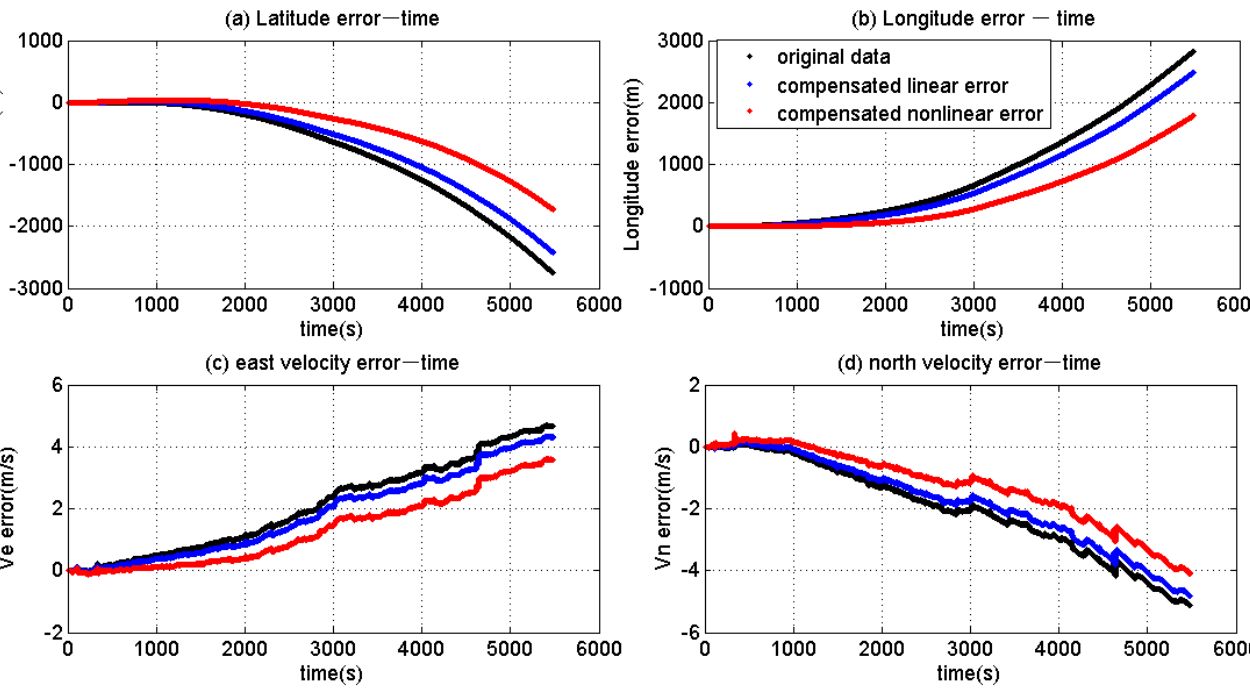
Figure 18. Position error and velocity error.